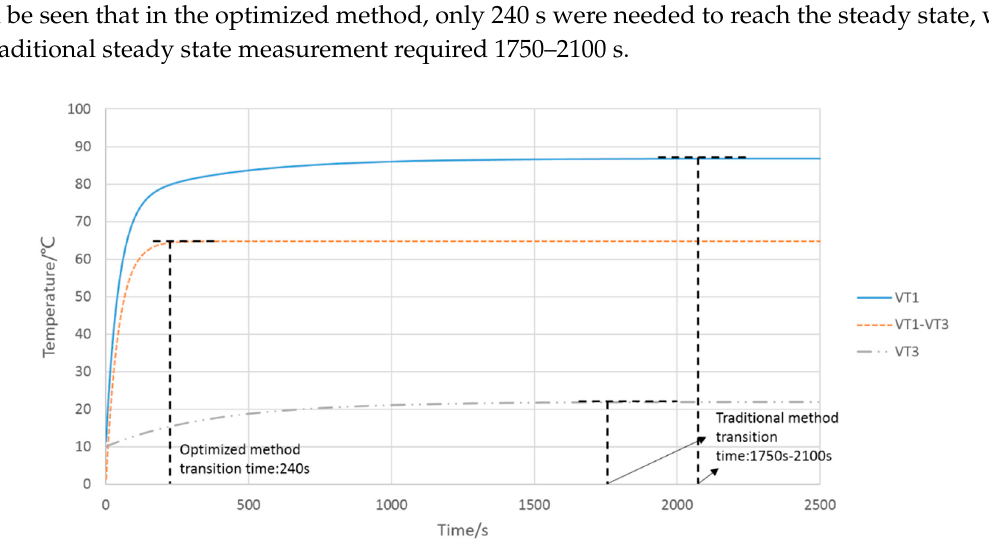
Figure 3. Simulation diagram of the traditional measurement method and the optimized measurement method.